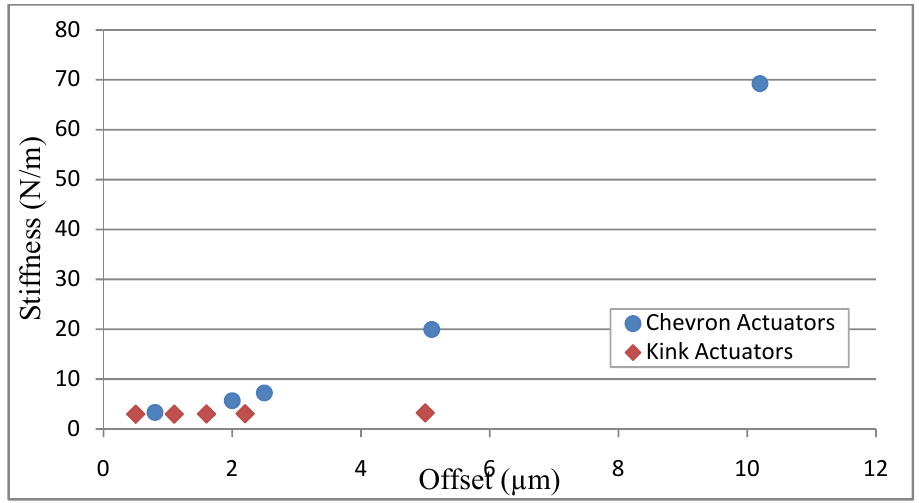
Figure 7. Comparison of the simulated stiffness vs . offset for chevron and kink